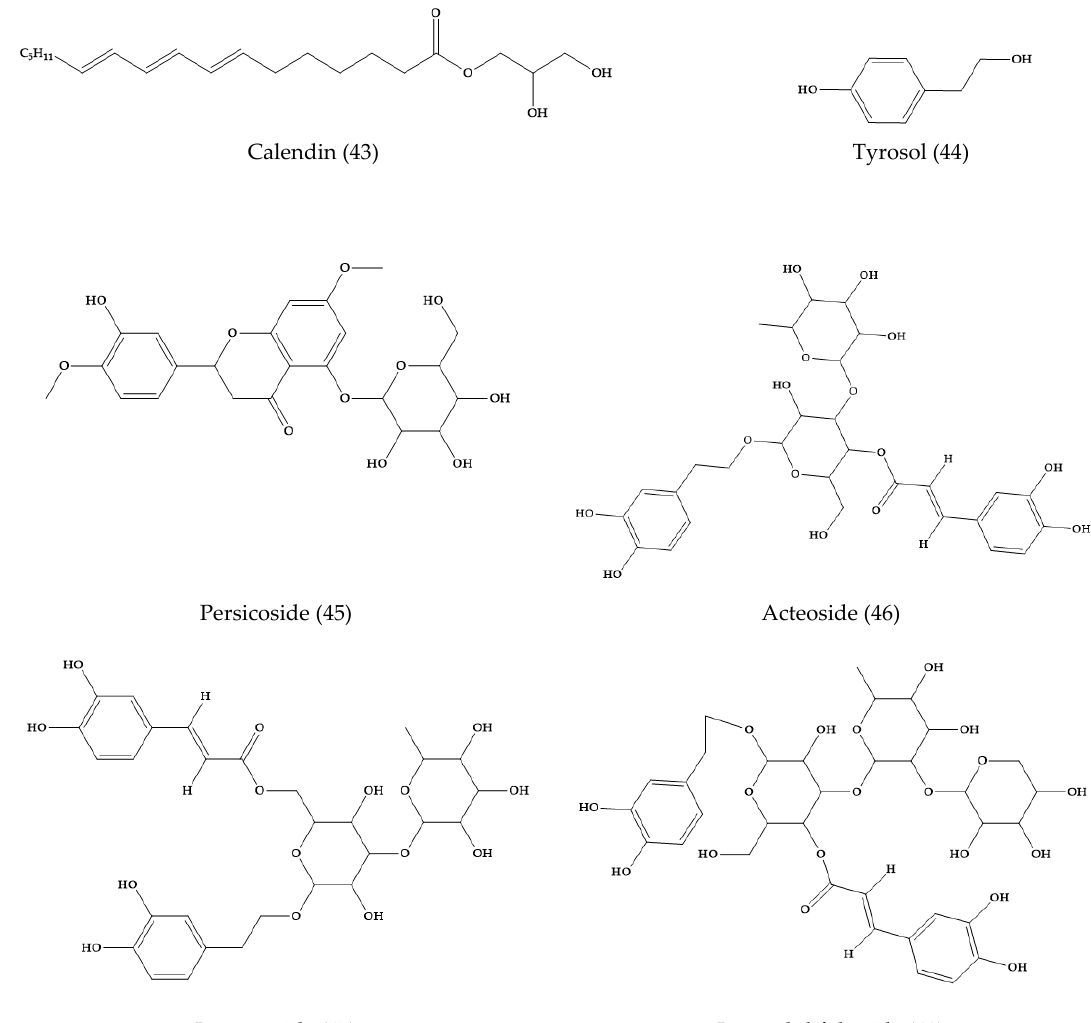
Figure 8. Phytoconstituents from Veronica persica .